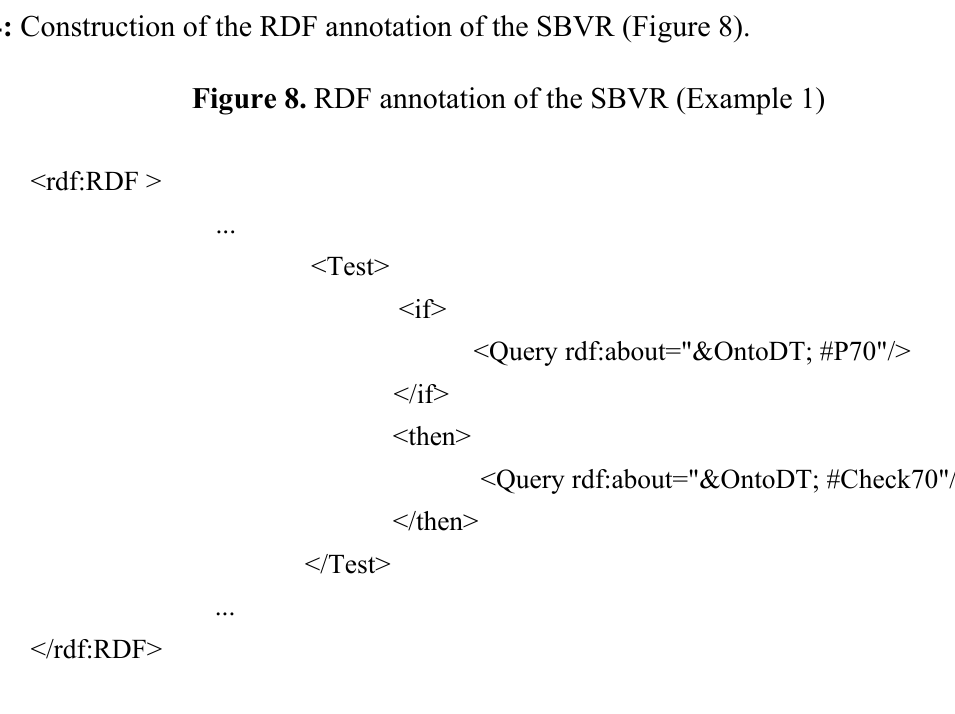
Figure 7. SPARQL query of the consequent (Example 1).